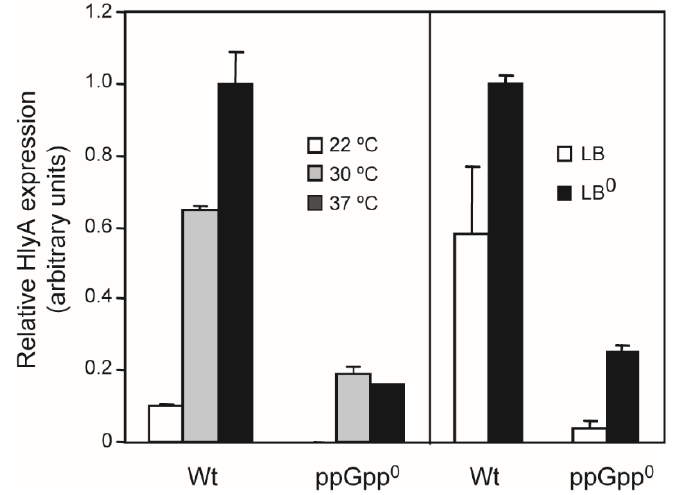
Figure 5. Thermo- and osmo-regulation of the hlyCABD II operon. Cultures of the Wt (AAG1) and ppGpp 0 (JFV2) carrying the plasmid pSF4000 were grown up to an OD 600nm of 0.8 either in LB at 22, 30, and 37 °C (left panel) or at 37 °C in either LB (170 mM NaCl) or LB 0 (0 M NaCl) (right panel). The protein content of the cell-free supernatants was analyzed (10% SDS-PAGE and Coomassie blue stained) and the relative amount of α -hemolysin is plotted in the bar diagram. After band intensity quantification, a value of 1.0 was arbitrarily given to the amount of α -hemolysin detected in cultures of the Wt strain in LB at 37 °C. Data shown are mean and standard deviation of toxin determination from two independent cultures.